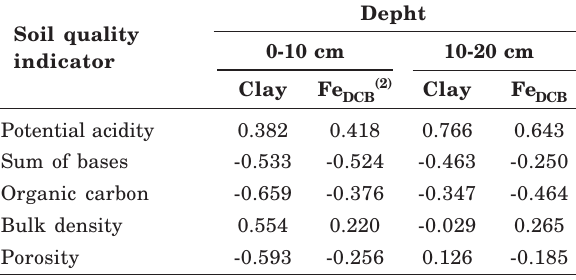
Table 2. Linear correlation coefficient (1) of intrinsic soil properties with indicators of soil quality in two depth ranges under three land uses (conventional agriculture, no-tillage and native